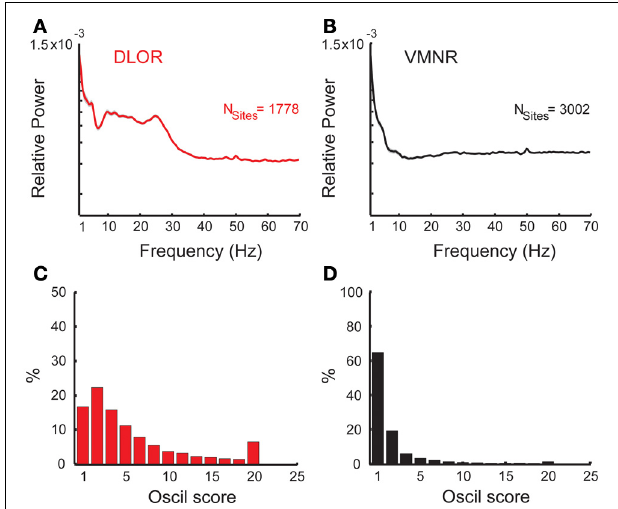
FIGURE 4 | Examples of power spectra and coherence functions with different oscillation and synchronization scores. (A) Three examples of power spectra with low, medium, and high oscillation ( oscil ) scores. (B) Three examples of STN coherence functions with low, medium, and high synchronization ( sync ) scores. The dashed horizontal and continuous lines denote the confidence interval of 99 and 95% respectively. Sampling duration equals 33.4, 14.5, and 35.1s for the power spectra examples and 40.2, 41.5, and 40.6s for the coherence examples (yielding similar confidence intervals for the coherence